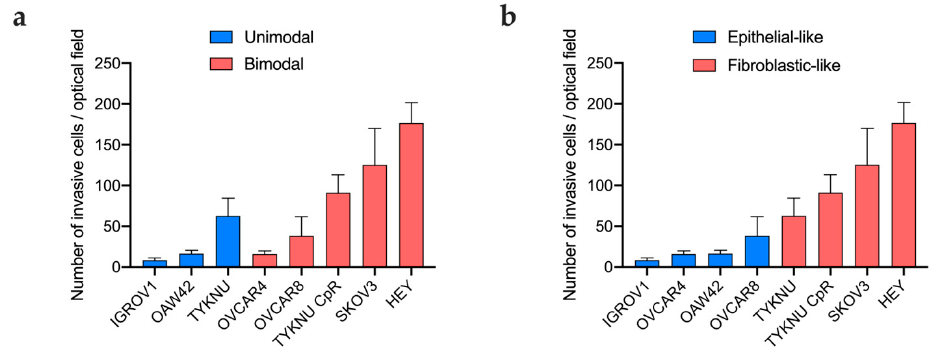
Figure 2. Number of invasive cells for each EOC cell line according to stiffness distribution profile ( a ) and morphological classification ( b ).